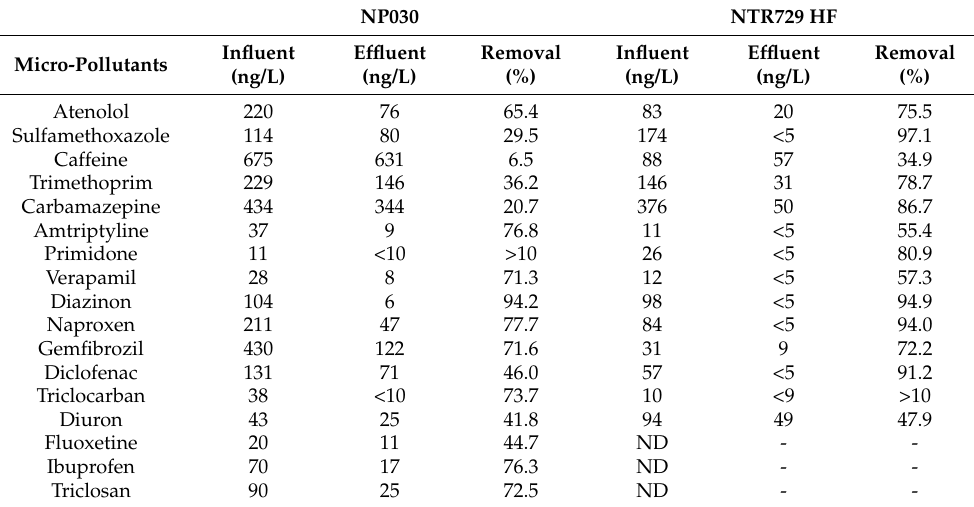
Table 4. Removal of micro-pollutants by two different hydrophilic NF membranes (NP030 and NTR729HF) at operating pressure of 4 bar. NP030 NTR729